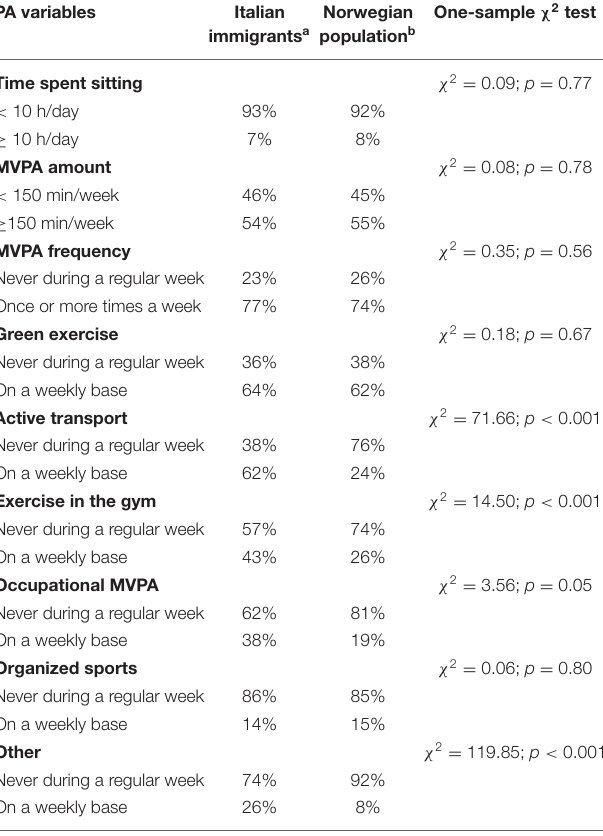
TABLE 2 | Physical activity profile of Italian immigrants in Norway compared with the Norwegian general population. PA